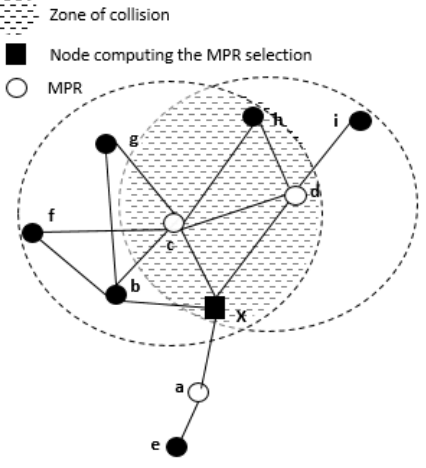
Figure 3. MPR computation of original